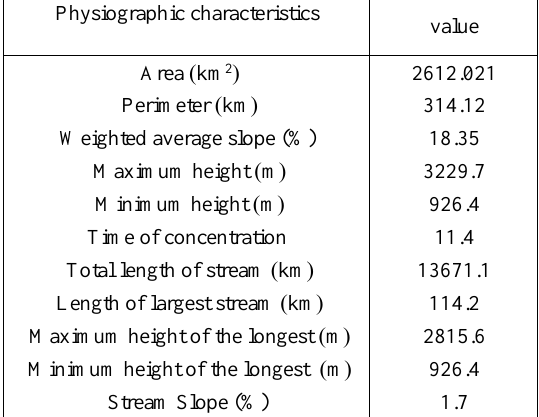
Table 1.Physiographic characteristics of Zilberchai